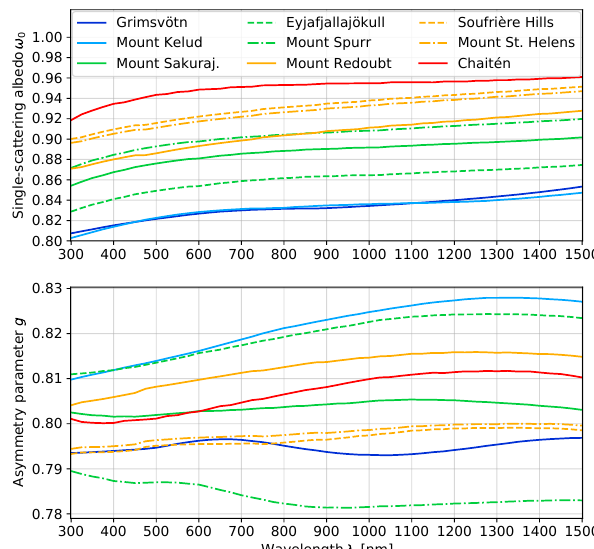
Figure 11. Modeled wavelength-dependent optical properties for ashes from different volcanoes. More details on the ash samples are given in Table 1 of Vogel et al. (2017). The colors indicate ash type: basalt is dark blue, basaltic andesite is light blue, andesite is green, dacite is orange, and rhyolite is red (see Fig. 7 of Vogel et al., 2017 for